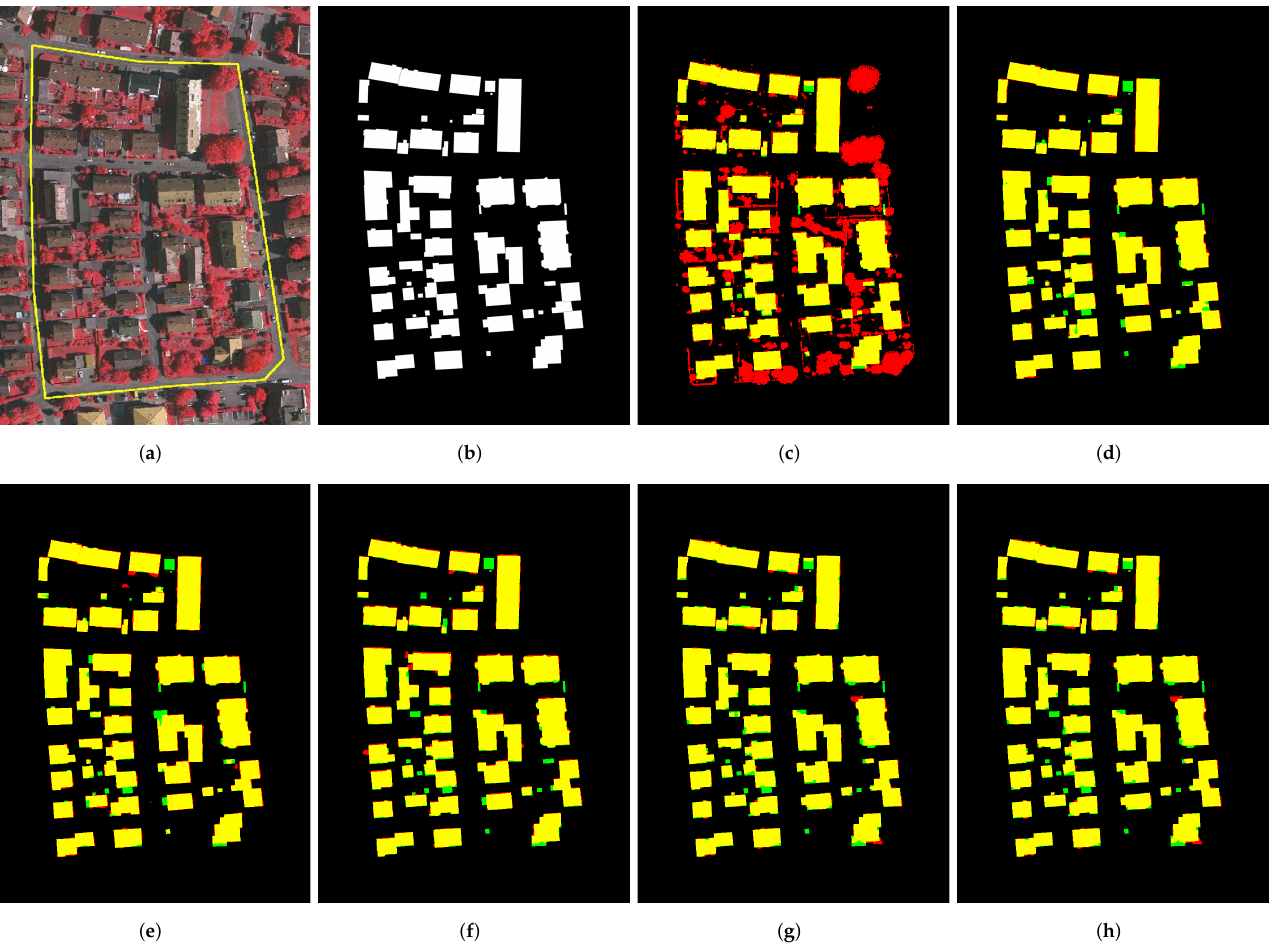
Figure 9. The building extraction results on the third test area. ( a ) Orthorectified image; ( b ) ground truth (white regions denote the buildings); ( c ) nDSM; ( d – h ): result of DeepLabv3+, U-Net, the HOA method, the beSH+IFCC method and the biSH+IFCC